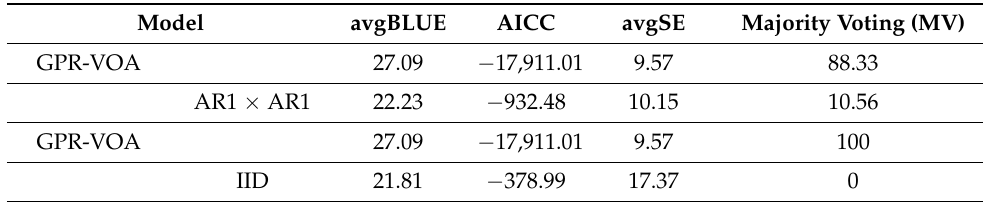
Table 4. Model comparison using AICC, average standard error (avgSE) of BLUE, and majority voting. Overall average of the BLUE is presented as